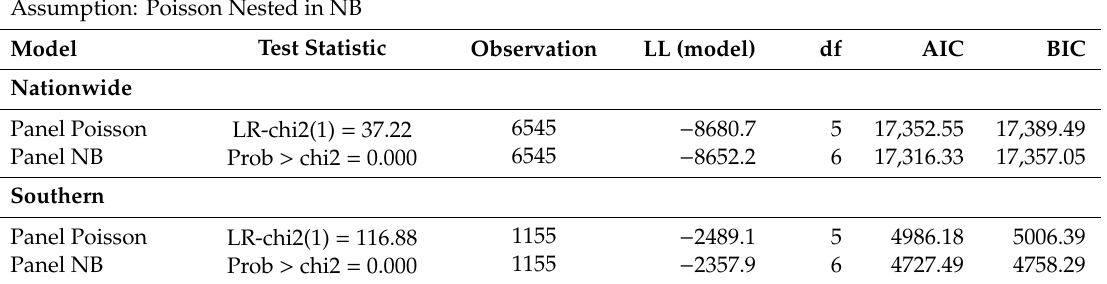
Table 4. Likelihood ratio test